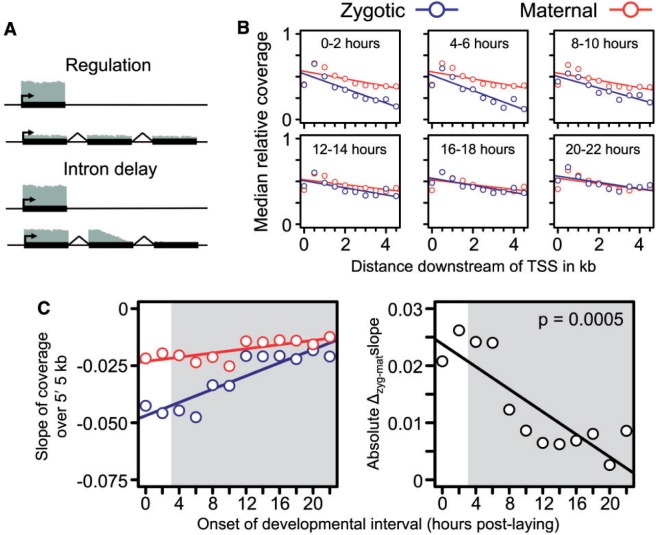
Patterns of transcript coverage are consistent with intron delay. (A) Illustration of the predicted read coverage (indicated as gray bars) along short and long transcripts under transcriptional initiation versus intron delay models explaining the lower expression of long zygotic transcript during early development. Under a regulatory model, all transcripts should have relatively similar read coverage along their lengths. Under the intron delay model, relative coverage should decline along the length of the transcript; however, the slope of this decline should become less negative as cell cycles lengthen. (B) As predicted by the intron delay model, read coverage declines more rapidly over the first 5 kb of transcripts for zygotic (blue) as compared with maternal (red) transcripts. (C) The difference in measured slopes decreases significantly over the 12 2-h developmental windows. Slopes are derived from linear regressions of median coverage over the embryonic time points, and the P value of the regression of slope differences over the timecourse is indicated in the panel. The area shaded in gray indicates postgastrulation time points during which the expression levels of maternally deposited genes may include significant contribution from zygotic transcription. Panel B with all 12 time points is presented in supplementary figure S2, Supplementary Material online.